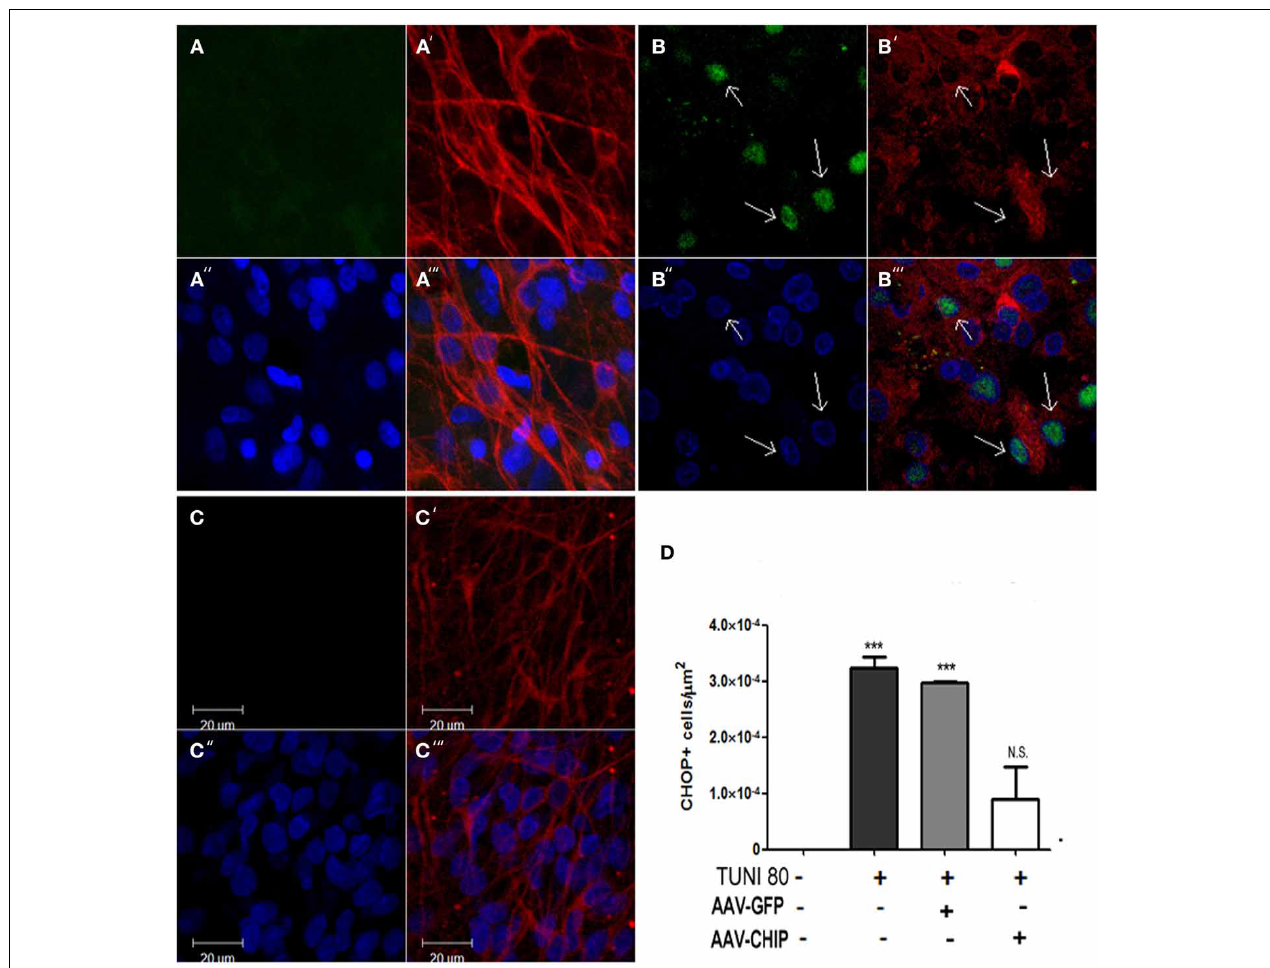
FIGURE 7 | Overexpression of CHIP diminishes CHOP/GADD153 positive neurons after Tunicamycin treatment. Immunofluorescence for CHOP (green) and TUJ-1 (red) counterstained with nuclear marker TO-PRO3 (in blue). (A–A”’) Vehicle treated slice. (B-B”’) Tunicamycin treated slice.